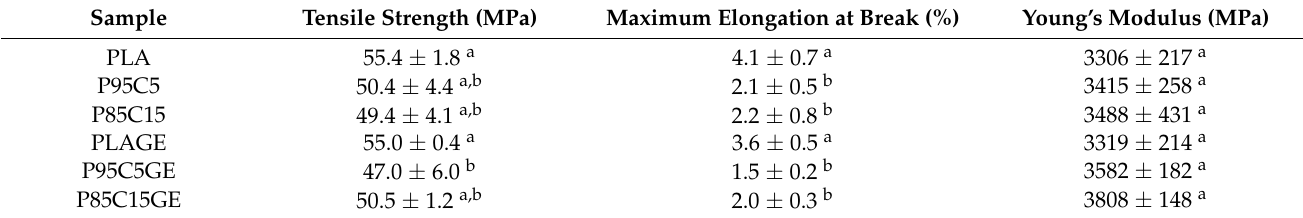
Table 3. Results of the tensile tests of neat PLA and the